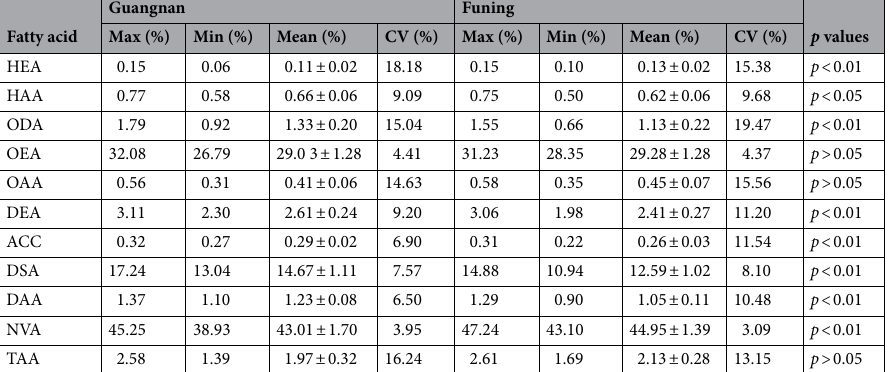
Table S8). The percentage of seed oil renged from 48.31 ± 0.47% to 67.93 ± 1.07% (Table 2). The CVs were 5.92% and 4.57% in Guangnan and Fujing, respectively. It is worth noting that the seed oil content in individuals was significantly different ( p < 0.01) between Guangnan (58.15 ± 3.44%) and Funing (64.16 ± 2.93%). Previous stud- ies have suggested that seed oil content in M. oleifera was about 60.25% ± 2.5% 16 , 64.5% 15 , 51.3% and 52.7% 21 , and 51.7% and 56.8% 22 . However, these previous studies used a mixed seed sample from trees and did not inves- tigate the differences in seed oil concentration among individual trees or between sites with divergent climates. Eleven compounds were identified from the analysis of the fatty acids in the seed oil. Together, these eleven compounds contributed between 91.39 to 96.34% of the total lipids. The most abundant fatty acid was ner- vonic acid (38.93–47.24%), and the other major fatty acids were octadecenoic acid (26.79–32.08%), docosenoic acid (10.94–17.24%), dodecenoic acid (1.98–3.11%), tetracosanoic acid (1.39–2.61%), octadecadienoic acid (0.66–1.79%), docosanoic acid (0.90–1.37%), hexadecanoic acid (0.50–0.77%), octadecanoic acid (0.31–0.58%), arachidic acid (0.22–0.32%), and hexadecenoic acid (0.06–0.15%) (Table 3). Trees in Funing had significantly higher nervonic acid content in their seed oils than did those at Guangnan ( p < 0.01), but the docosenoic acid content in the seed oil was significantly higher in trees at Guangnan ( p < 0.01) than those at Funing, and the con- centration of octadecenoic acid in the seed oil did not differ significantly between the two sites ( p > 0.05) (Table 3). That these 11 fatty acids are the most prevalent in M. oleifera seed is largely consistent with the findings of other studies. Tang et al. 16 identified ten of eleven fatty acids above in seed oil, but did not find hexadecenoic acid. The largest fraction was represented by nervonic acid (55.70%), followed by octadecenoic acid (23.81%), docosenoic acid (13.13%), tetracosanoic acid (2.65%) and dodecenoic acid (1.28%). Peng et al. 32 identified the same ten fatty acids as Tang et al. 16 , with the major components being nervonic acid (33.17 ± 2.75%), octadecenoic acid (27.82 ± 2.04%), docosenoic acid (12.90 ± 0.96%), arachidic acid (3.91 ± 1.28%), dodecenoic acid (3.04 ± 0.70%), and tetracosanoic acid (2.78 ± 0.37%). Cao et al. 23 reported ten fatty acids in M. oleifera seed oil, but in this case the analysis identified linolenic acid (0.55%), but neither octadecanoic acid nor arachidic acid, and the fatty acid at the highest concentration was octadecenoic acid (37.88%) rather than nervonic acid (32.15%). However, across all of these studied, the three fatty acids present in the largest amounts were nervonic acid, octadecenoic acid and docosenoic acid, which together made up more than 73% (to as much as 92%) of the total lipids. Ou 15 reported that the nervonic acid content alone could reach up to 67% of the total lipids. Of all the fatty acids, nervonic acid had the lowest CVs (3.95% and 3.09% at Guangnan and Funing , respec- tively), followed by octadecenoic acid (4.41% and 4.37%), and docosenoic acid (7.57% and 8.10%), docosanoic acid (6.50% and 10.48%), arachidic acid (6.90% and 11.54%), hexadecanoic acid (9.09% and 9.68%), dodecenoic reported the following CVs from fatty acids in M. oleifera seed oil: octadecenoic acid (7.32%), docosenoic acid (7.44%), nervonic acid (8.30%), docosanoic acid (12.07%), tetracosanoic acid (13.14%), hexadecanoic acid vonic acid, octadecenoic acid, docosenoic acid, is relatively stable in M. oleifera seed oil. The lipid biosynthesis is influenced by environmental factors such as temperature and rainfall 33,34 . Many stud- ies indicated that temperature was negatively correlated with seed oil concentration 35–37 . Qiao et al. 38 reported that seed oil content of Acer truncatum showed significant negative correlations with both annual average temperature and annual rainfall. Nevertheless, some studies showed that seed oil content increased with the optimum tem- perature, above which the oil concentration declined 39–41 . We found that seed oil content was significantly higher in the samples from Funing than those from Guangnan (Table 2). This showed higher temperature could improve seed oil content of M. oleifera . Composition of fatty acid varied with temperature and rainfall. Temperature plays